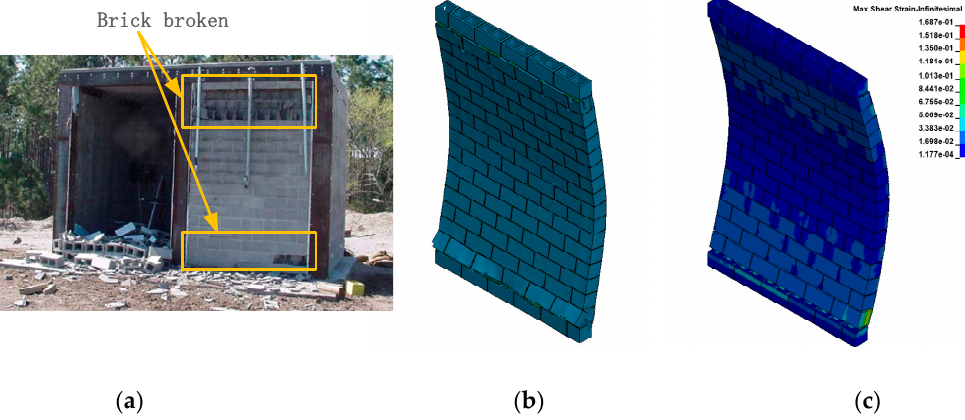
Figure 6. Dynamic responses of the wall in Test 1: ( a ) retrofitted with SPUA of 3.175 mm; ( b ) No Figure 6. DynamicresponsesofthewallinTest1: ( a )retrofittedwithSPUAof3.175mm; ( b ) No retrofitting. retrofitting.